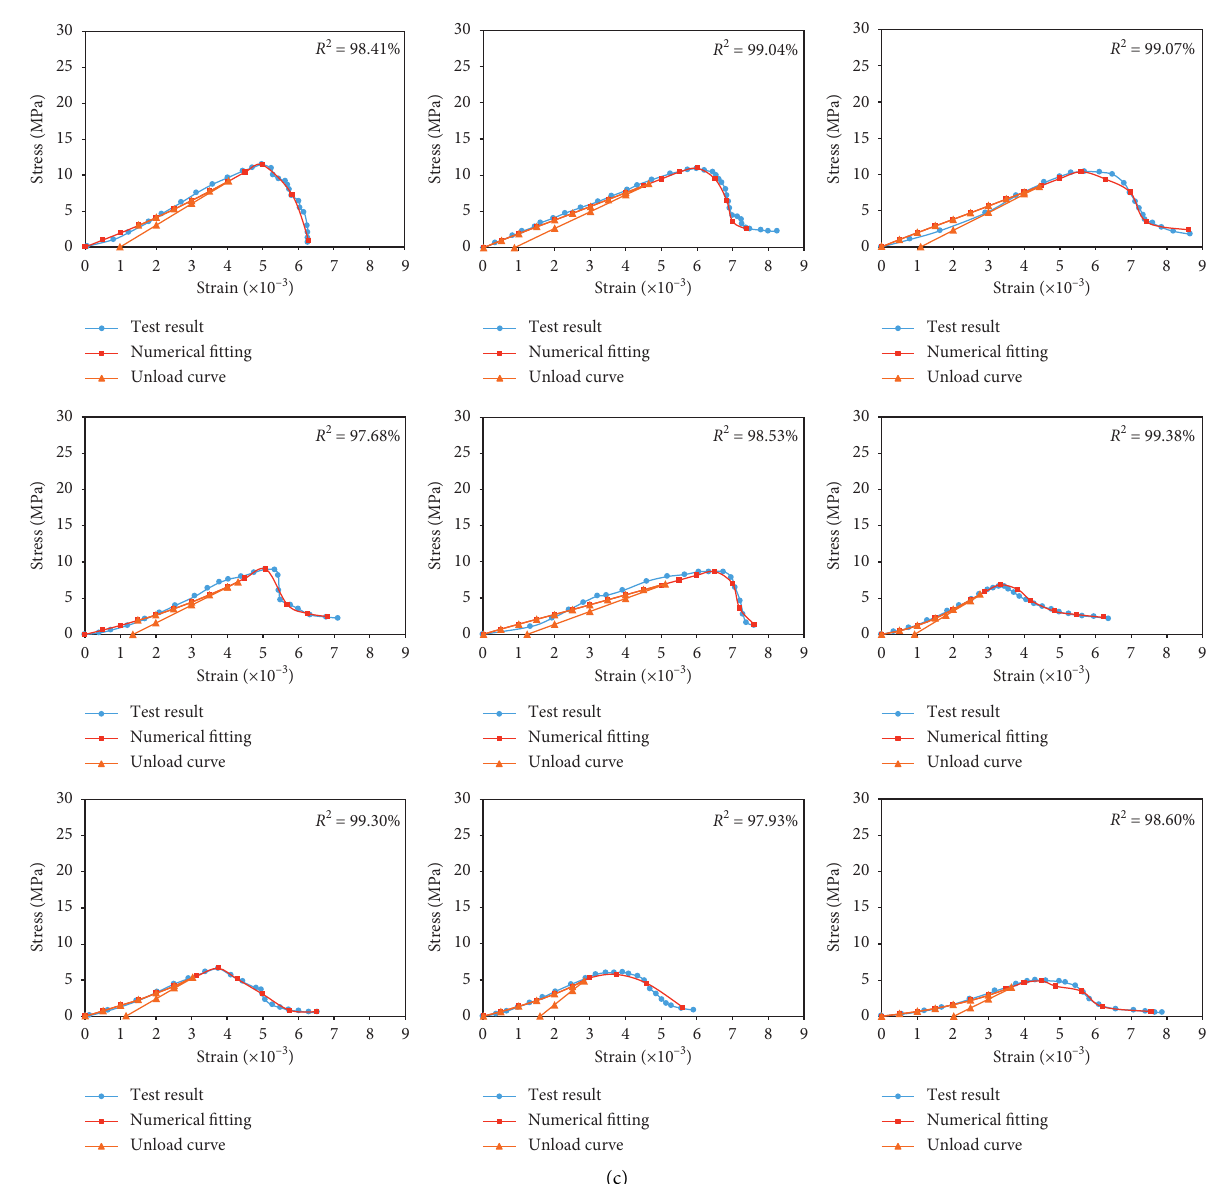
Figure 4: Numerical fitted stress-strain and unload curves of the 27 coal specimens by the uniaxial compressive test: (a) No .1 to No. 9